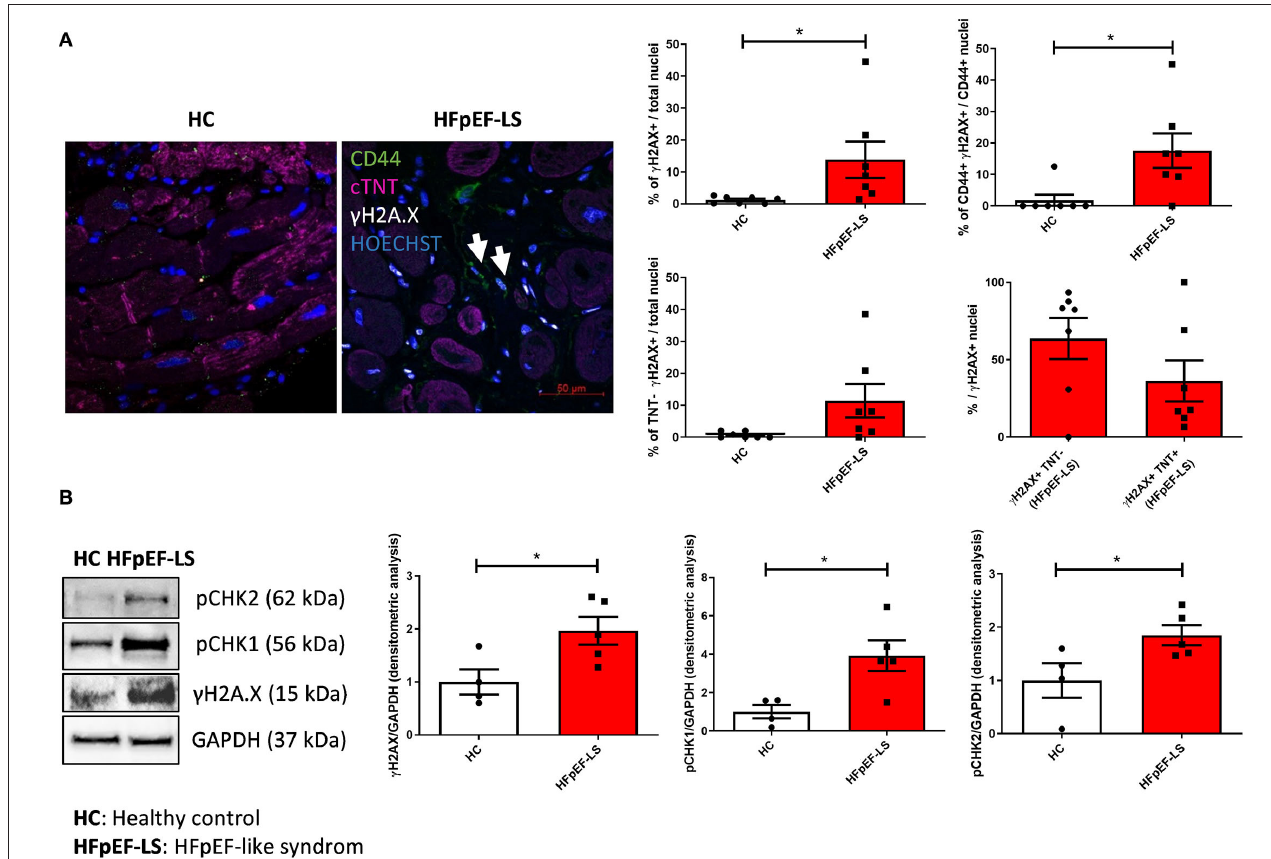
FIGURE 1 | Aortic valve stenosis with HFpEF-like syndrome cardiac biopsies exhibit DDR activation. (A) Representative IF images of γ H2AX (white), CD44 (green), and cTNT (pink) of HFpEF and HC cardiac tissue sections. Nuclei are counterstained with Hoechst 33342 (blue). Arrows indicate cells double positive for CD44 and γ H2AX. The left panels show the percentages of cells positive for γ H2AX, the percentages of C-MSC (positive for CD44) expressing γ H2AX, the percentages of non-cardiomyocytes (cTNT negative) expressing γ H2AX, and the comparison between percentages of cardiomyocytes (cTNT positive) vs. non-cardiomyocytes (cTNT negative) among the cells positive for γ H2AX. * p < 0.05. (B) Western blot analysis (left) of γ H2AX, pCHK1 and pCHK2 in HFpEF and HC cardiac tissue extracts. The housekeeping GAPDH is shown for normalization. Graphs on the right panels: densitometric analyses of γ H2AX, pCHK1, and pCHK2 levels, normalized on GAPDH. * p <